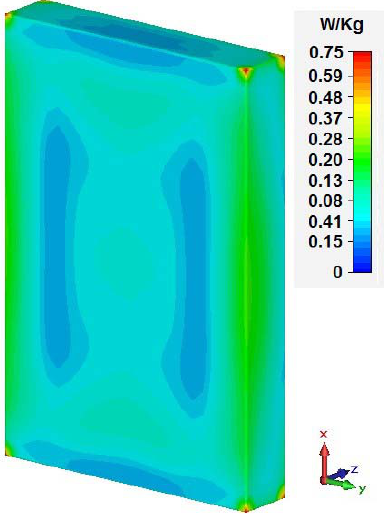
Figure 10. SAR distribution for close dipole at the frequency of 867 MHz on blood bag parallelepiped rounded wedges.